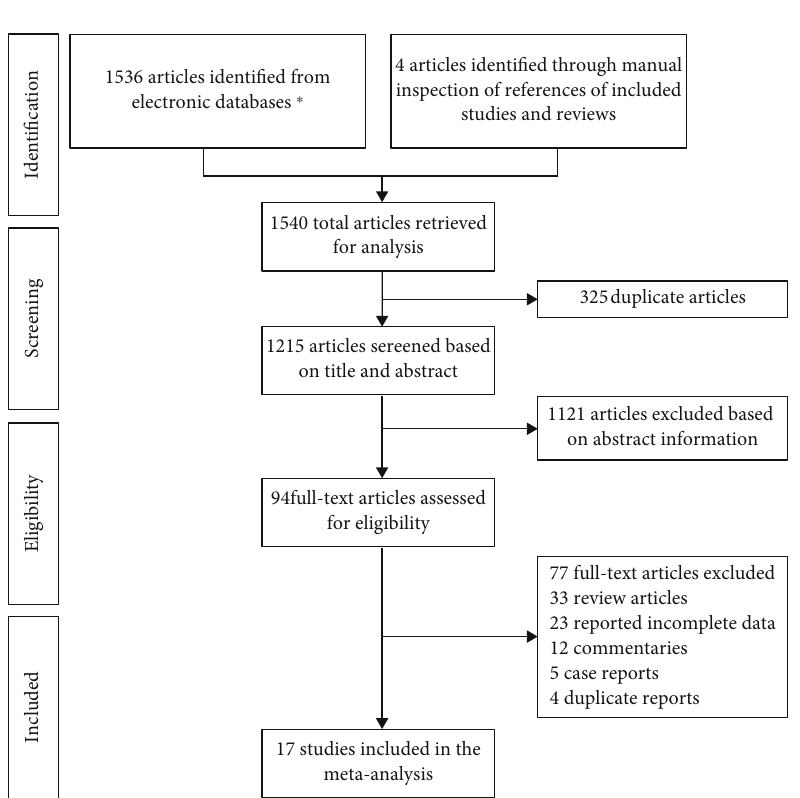
Figure 1: Summary of the literature identi fi cation and selection process. ∗ signi fi es Web of Science (442), PubMed (209), Scopus (490), Embase (117), Cochrane (71), ProQuest (34), CNKI (80), WanFang (61), VIP (10), and SinoMed